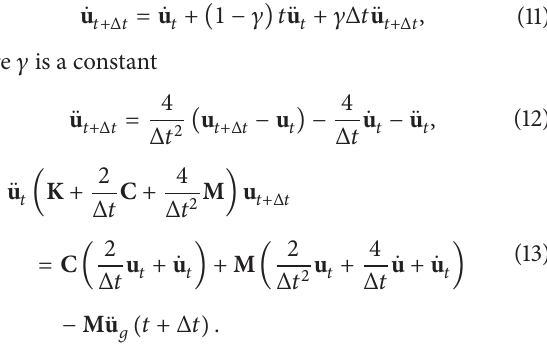
Figure 1: El-Centro seismic